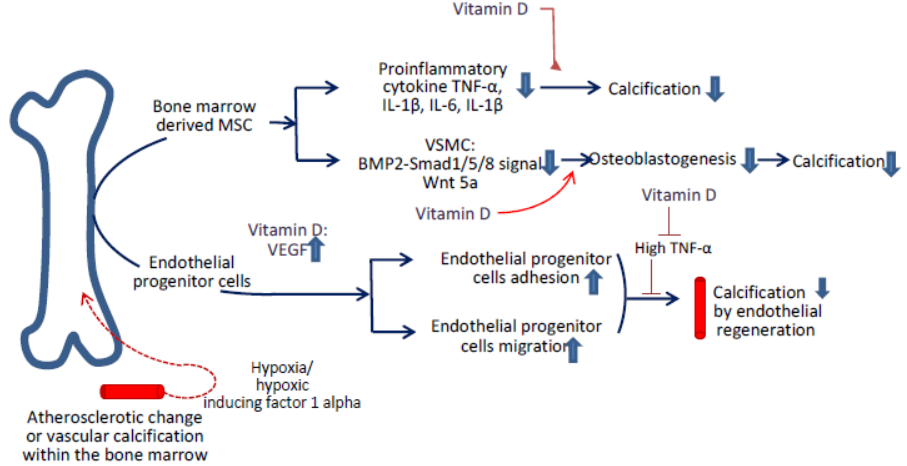
Figure 2. The adjunctive role of vitamin D in treating vascular calcification based on MSCs and endothelial progenitor cells (EPCs). In physiological hypoxia, angiogenesis can repair a damaged endothelium by promoting the differentiation of EPCs. The circulating EPCs migrated and invaded the subendothelial region to replace the injured endothelial cells; they also regulated the differentiation of the surrounding stromal cells and therefore reduced calcification. The MSCs mitigated calcification by lowering the proinflammatory cytokines or reducing the VSMC osteogenic expression. Vitamin D served as the adjunctive role in mitigating calcification by influencing EPCs and MSCs in several manners. For EPCs, vitamin D enhanced the EPCs mobilization during angiogenesis by increasing the vascular endothelial growth factor (VEGF) release. Vitamin D also enhanced the EPC adhesion and migration. Under the inflammatory status, such as high TNF- α scenario, the further vascular calcifications could be lessened by the usage of vitamin-D. For MSCs, vitamin D influenced the secretion of proinflammatory cytokines, such as TNF- α, interleukin 1(IL -1), and interleukin 6 (IL-6), which might induce osteogenic MSCs. Vitamin D decreased the VSMC osteogenic differentiation by decreasing the BMP2-Smad1/5/8 (mothers against decapentaplegic homolog 1/5/8) signal or Wnt5a expression.